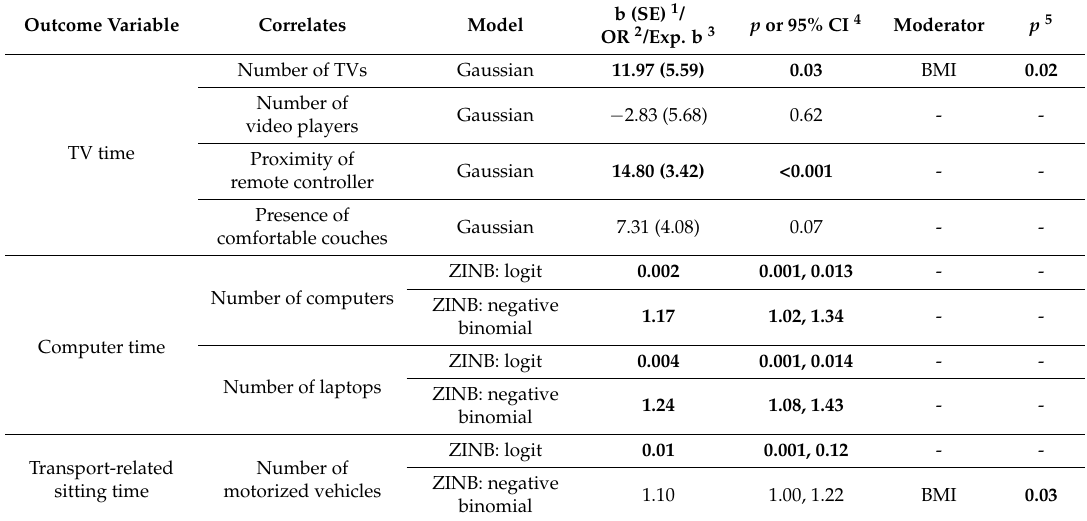
Table 2. Main associations between home environmental factors and domain-specific sedentary behaviors and moderating